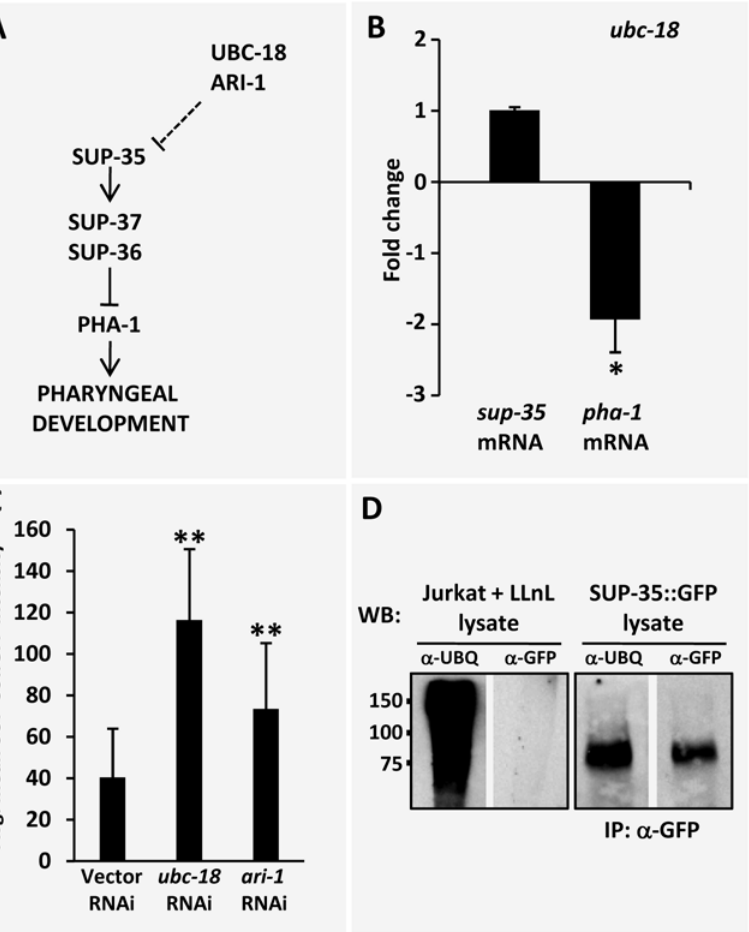
Figure 7. Regulation of sup-35 and pha-1 by UBC-18–ARI-1. (A) Testable model for the regulation of SUP-35 and PHA-1 by UBC-18–ARI-1. (B) Quantification of sup-35 and pha-1 endogenous mRNA levels in embryos by qRT-PCR in ubc-18(ku354 mutants using act-1 as an internal normalization control. Fold changes were obtained after normalizing to N2. Note that although pha-1 mRNA was significantly decreased in ubc-18 mutants, sup-35 mRNA levels were unaffected. (C) Quantification of SUP-35::GFP protein levels in embryos following RNAi inhibition of ubc-18 and ari-1 (also see Figure S1). Note that SUP-35::GFP protein levels were substantially increased following inhibition of ubc-18 and ari-1 . Animals assayed were of genotype pha-1(e2123); sup-36(e2217); fdEx57 (SUP-35:: GFP ) embryos of the genotype pha-1(e2123); sup-37(e2215); fdEx63 (SUP-35:: GFP showed similar trends (data not shown). Error bars (B and C) represent s.e.m. The means of the indicated groups were analyzed for significance using a two-tailed Student’s t-test (*p , 0.05 and **p , 0.000). (D) SUP-35::GFP was immunoprecipitated from whole worm lysates of strain WY518 using polyclonal anti- GFP antibodies. The immunoprecipitates were analyzed by western blot using monoclonal antibodies to either GFP or ubiquitin. Lysates from Jurkat cells grown in the presence of the proteosomal inhibitor LLnL were used as a positive control for ubiquitinated products and as a negative control for GFP. The expected size of the non-ubiquitinated SUP-35::GFP fusion protein is , 68 kDa.